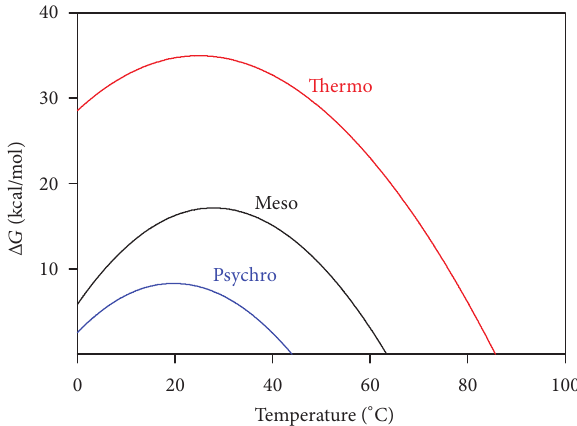
F 10: Gibbs free energy of unfolding, or conformational stability, of homologous extremophilic proteins. e work required to disrupt the native state is plotted as a function of temperature. e high stability of the thermophilic protein is reached by liing the curve towards higher free energy values, whereas the low stability of the psychrophilic proteins corresponds to a global collapse of the bell-shaped stability curve. Adapted from